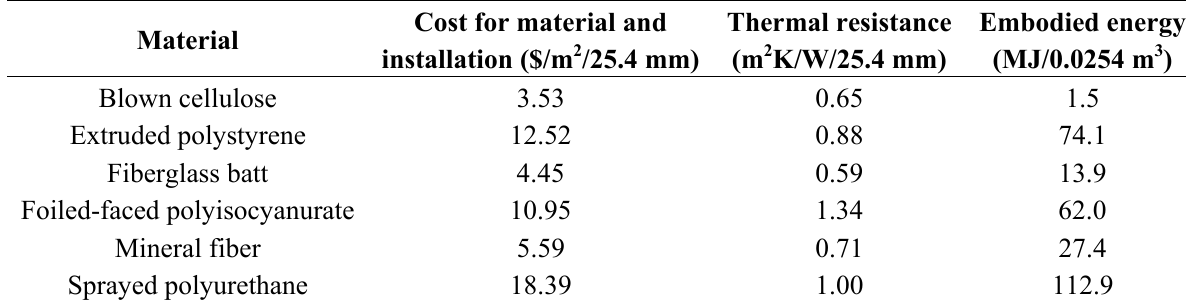
Table 4. Properties of some insulating